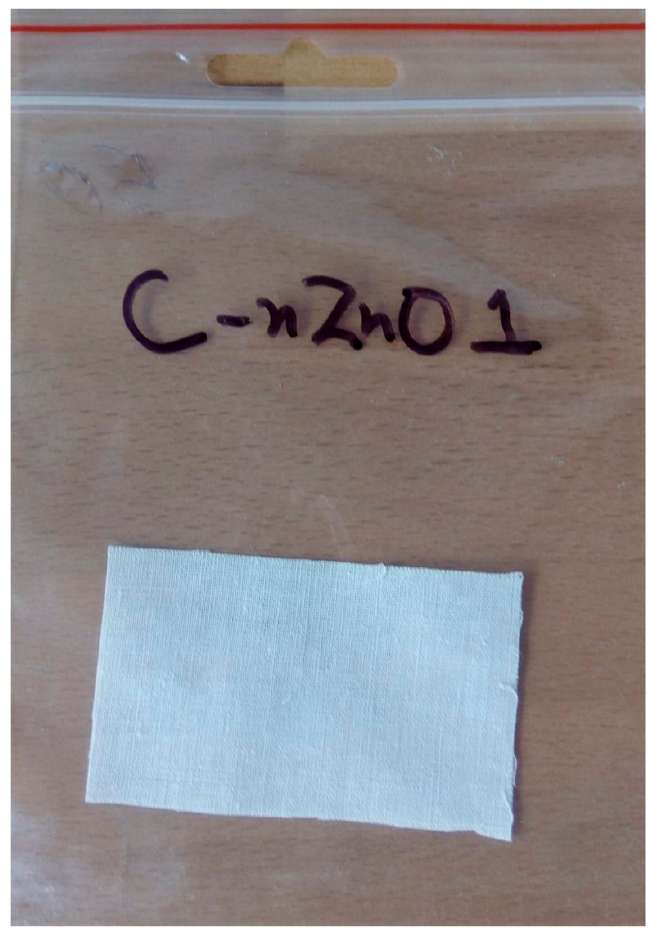
Figure 8. The real image of sample C-nZnO 1.